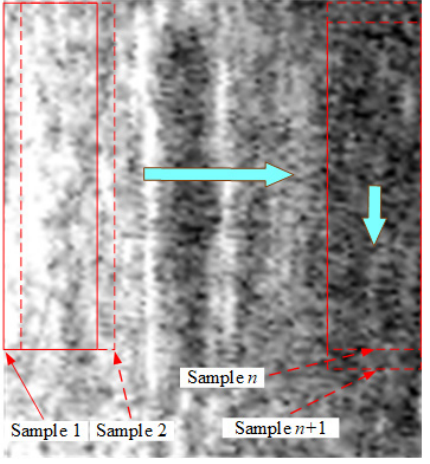
Figure 16. Divide the test image into several areas.